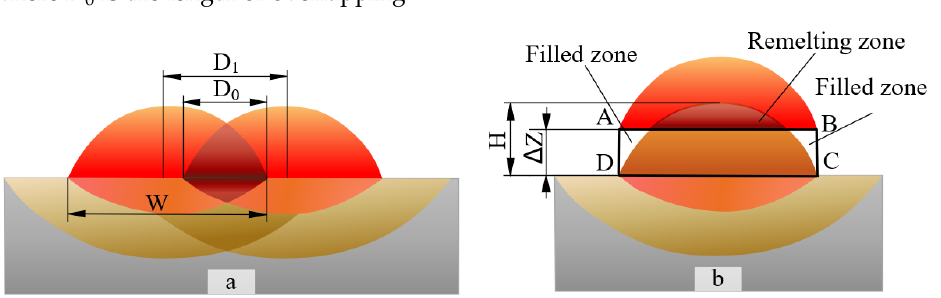
Figure 4. Schematic diagram of lapping model: ( a ) transverse overlapping, ( b ) longitudinal overlapping. For longitudinal overlapping (z-increment), a part of the liquid metal in the second layer would spread to both sides under the effect of surface tension and gravity, as Figure